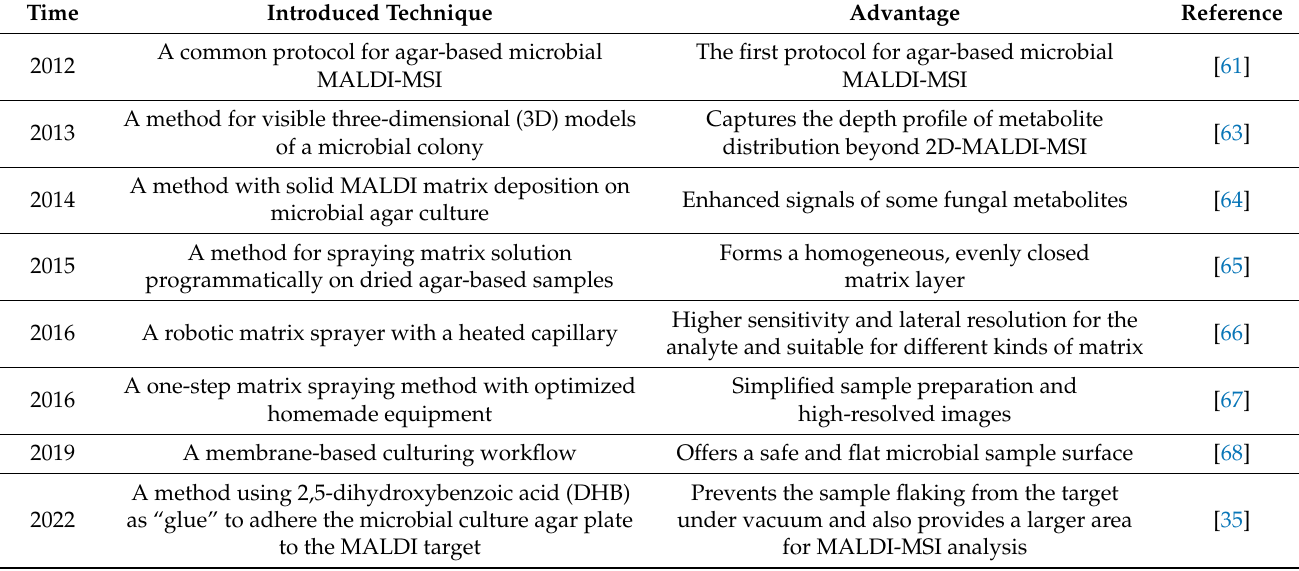
Table 2. Technical advances in sample preparation of microbial